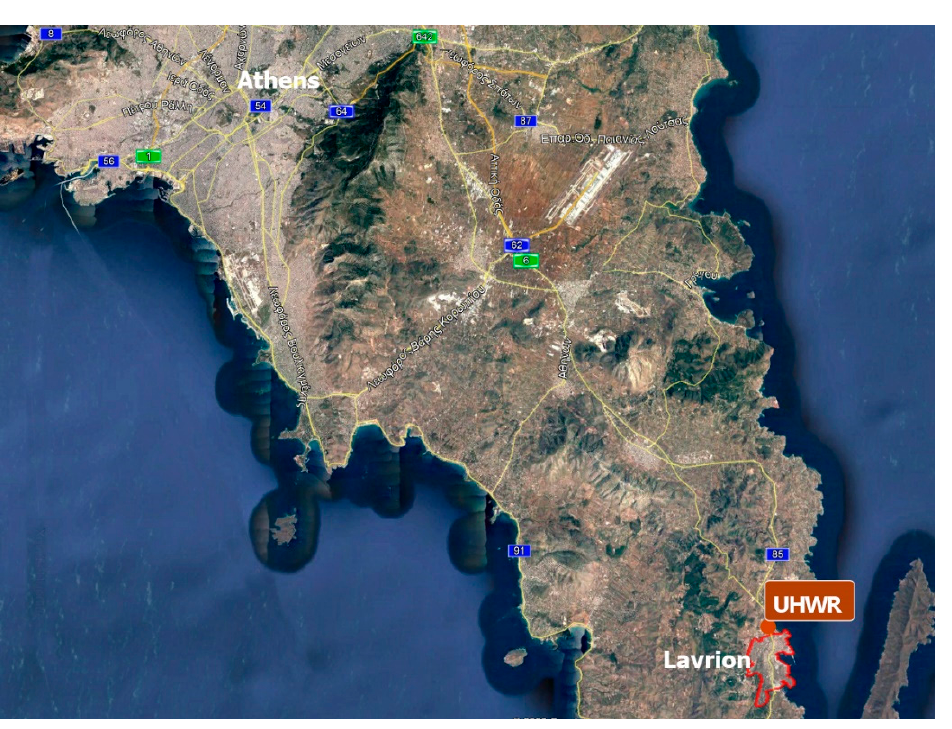
Figure 3. UHWR underground floor plan. Figure 4. Perspective of UHWR underground space. Before conducting this experiment, structural and technical characteristics of the un- derground space were taken into account, to make sure that it was safe to complete an